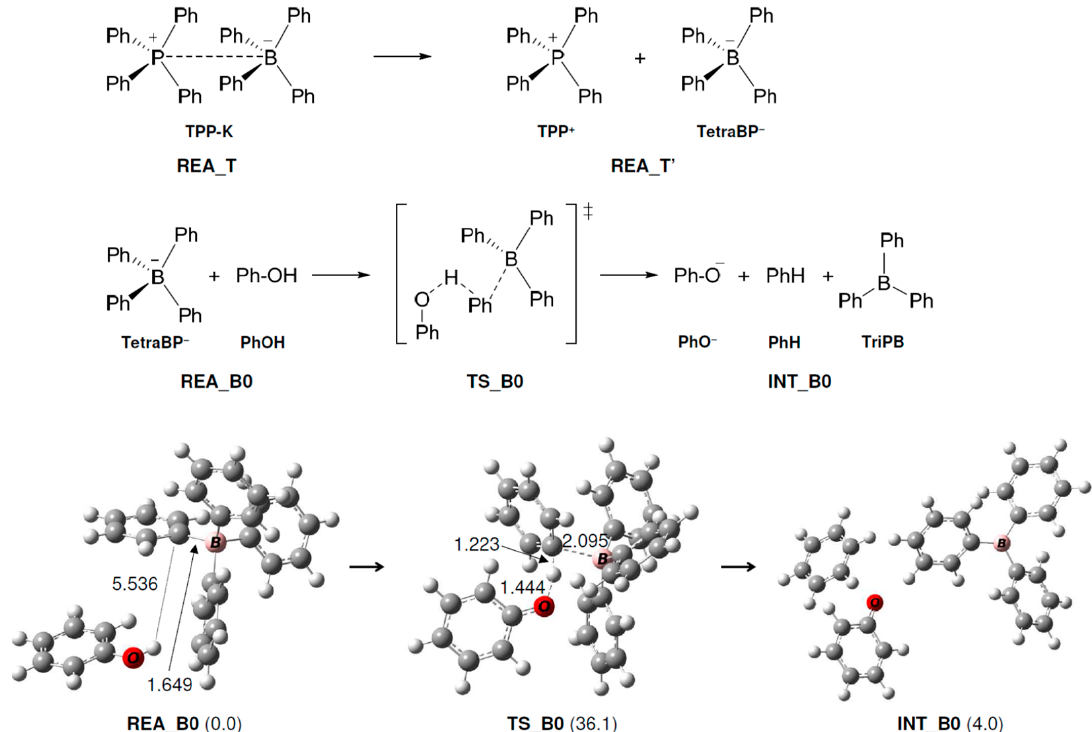
Figure 1. Geometry and free energy changes in the triphenylborane-forming reaction. The bond lengths are in Å. Relative free energies (kcal/mol) to REA_B0 are in parentheses.